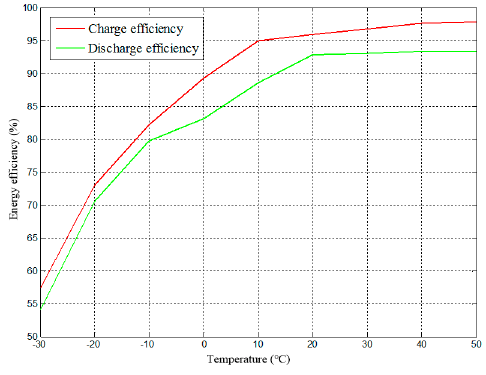
Figure 4. Discharge and charge efficiency as a function of temperature.